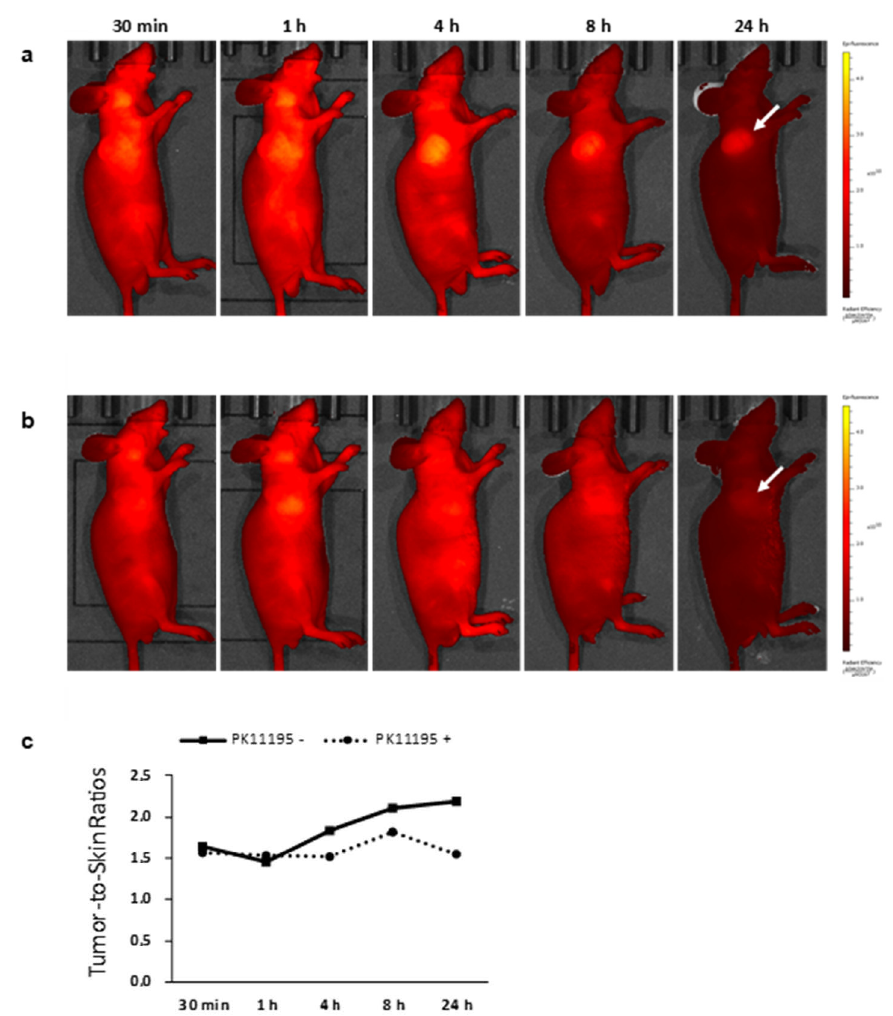
Figure 9. Fluorescence imaging study by IVIS Lumina XRMS. ( a ) Imaging of U87-MG xenograft model at 30 min, 1 h, 4 h, 8 h, and 24 h post-injection of TSPO-targeted NP of 200 µg. ( b ) Inhibition study using PK 11195 (10 mg/1 kg). ( c ) Tumor-to-skin ratios in mouse models with PK 11195 pre-injection or without PK11195 pre-injection. Reproduced with permission [38]. Copyright © 2021 Elsevier B.V. All rights reserved.